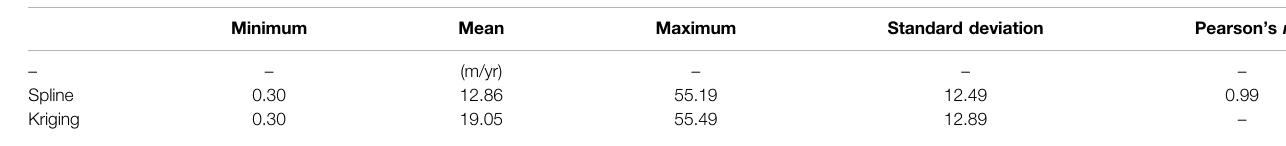
TABLE 3 | Main statistical characteristics of the interpolated velocity